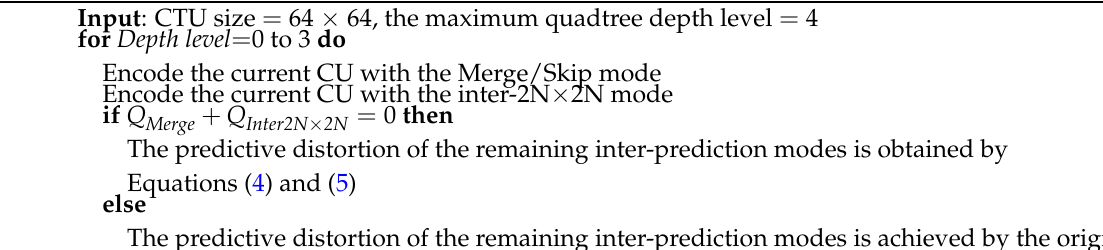
Algorithm 1 Proposed fast CU size decision method for the low complexity H.265/HEVC